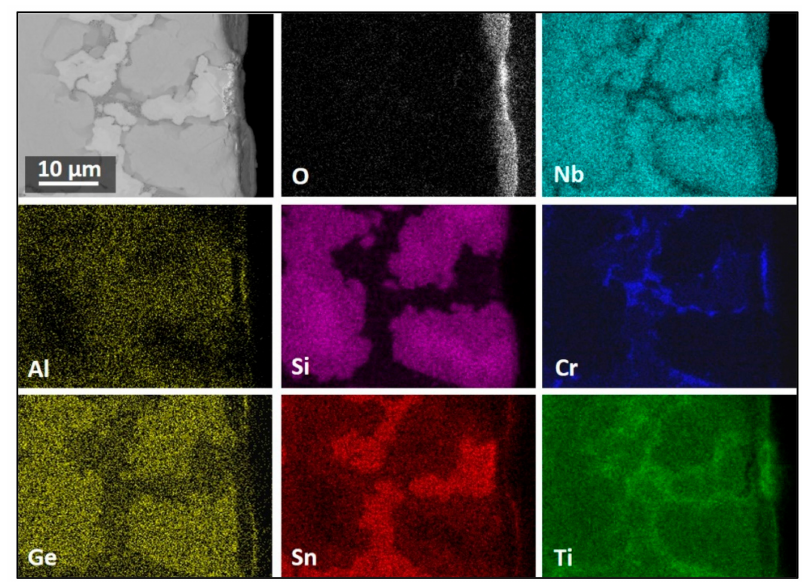
Figure 9. BSE image and X-ray elemental maps of a cross-section of the alloy OHS1 after isothermal oxidation in air at 800 ◦